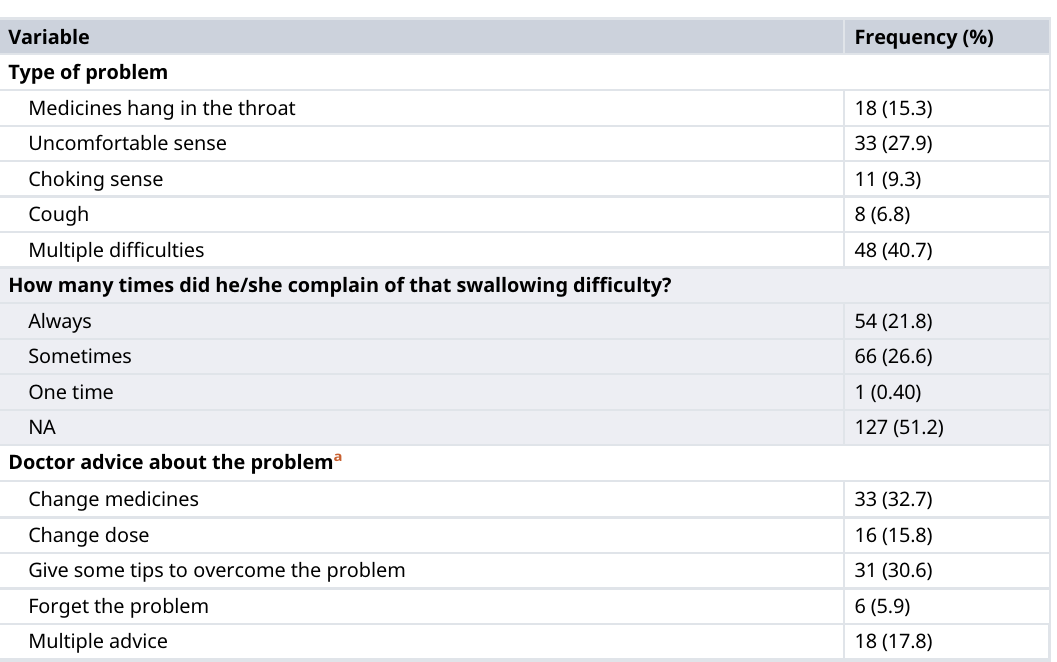
Table3.Swallowingproblemsinfluencingoralmedicinesadministrationformanagingchildhoodasreported by parents 47.6% ( N =